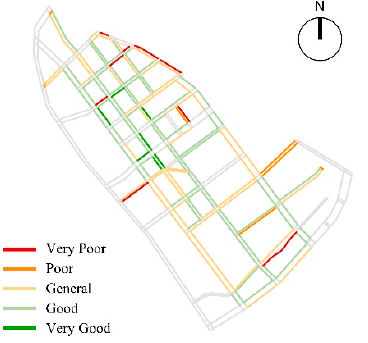
Figure 11. Comprehensive analysis of Pedestrian accessibility.